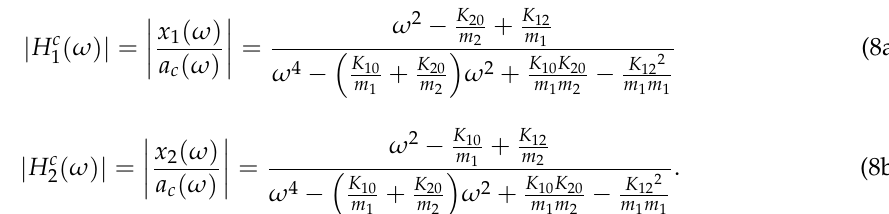
( b ) Figure 4. ( a ) Cross sectional illustration showing the layout of different types of coils; ( b ) the assembled superconducting gravity gradiometer (SGG) sensor.